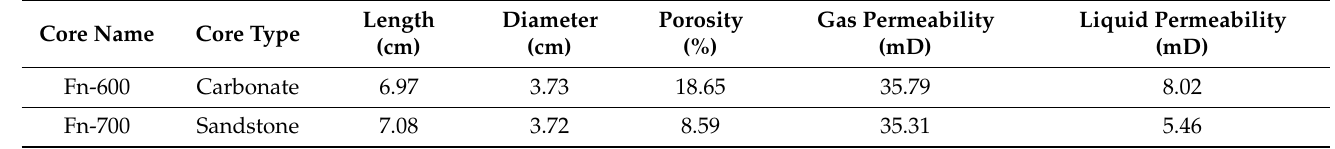
Table 1. Parameters of the cores